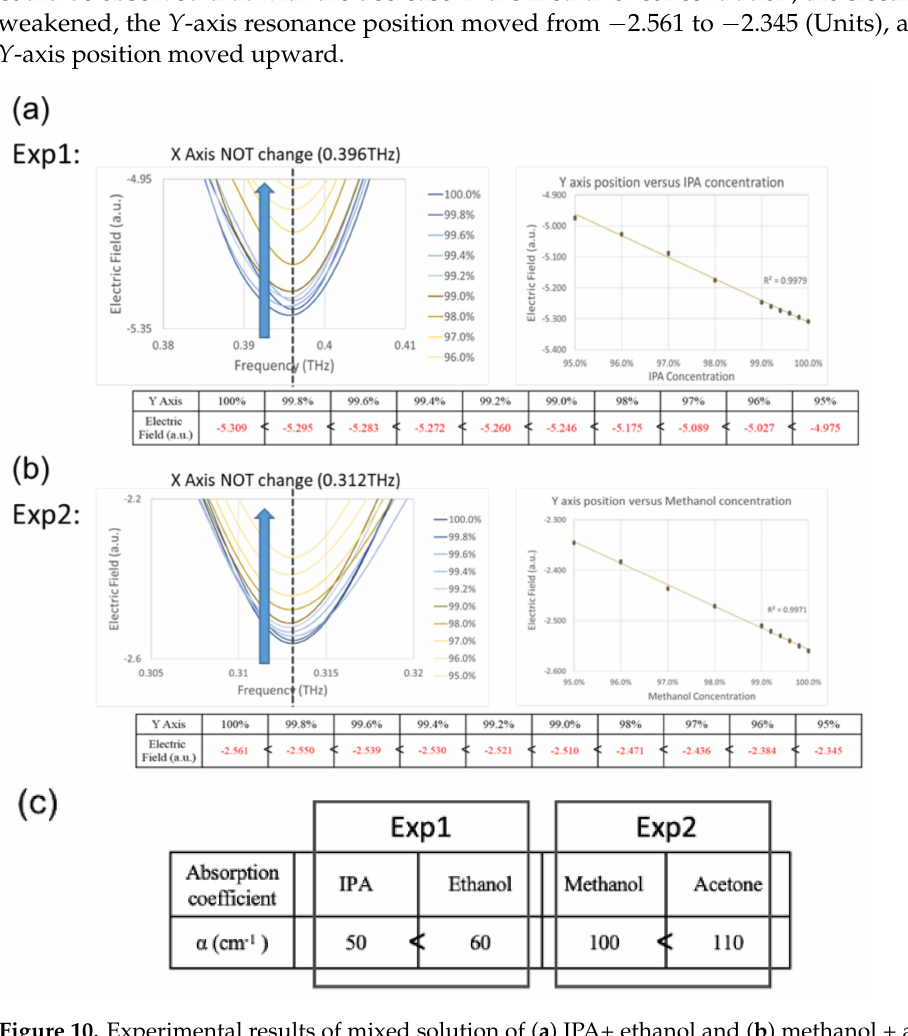
Figure 10. Experimental results of mixed solution of ( a ) IPA+ ethanol and ( b ) methanol + acetone. ( c ) Absorption coefficients of IPA, ethanol, methanol, and